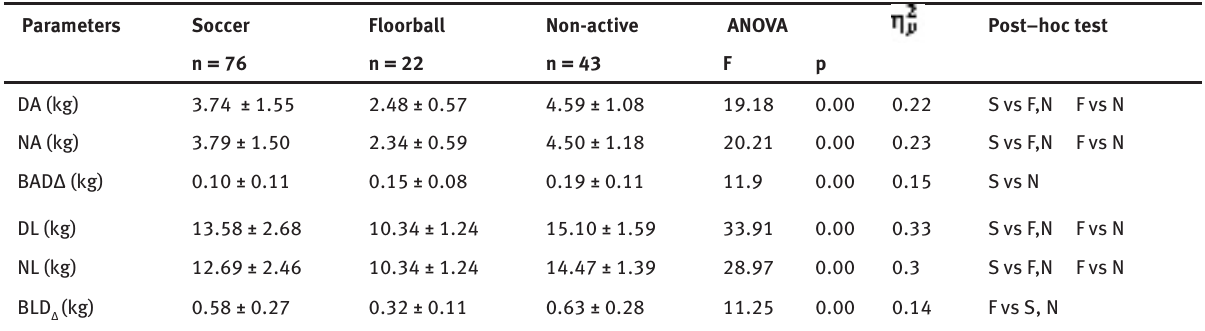
Table 2: Fluid segmental distribution differences between limbs with respect to different sport activities Parameters